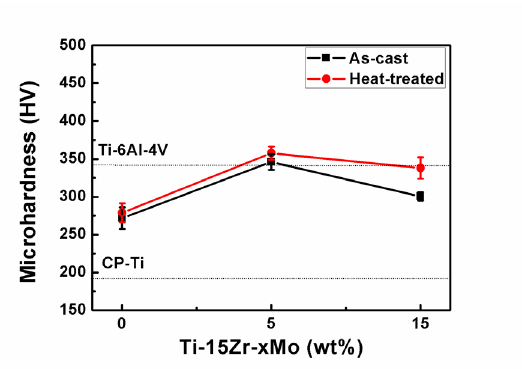
Figure 2 : Vickers microhardness values.